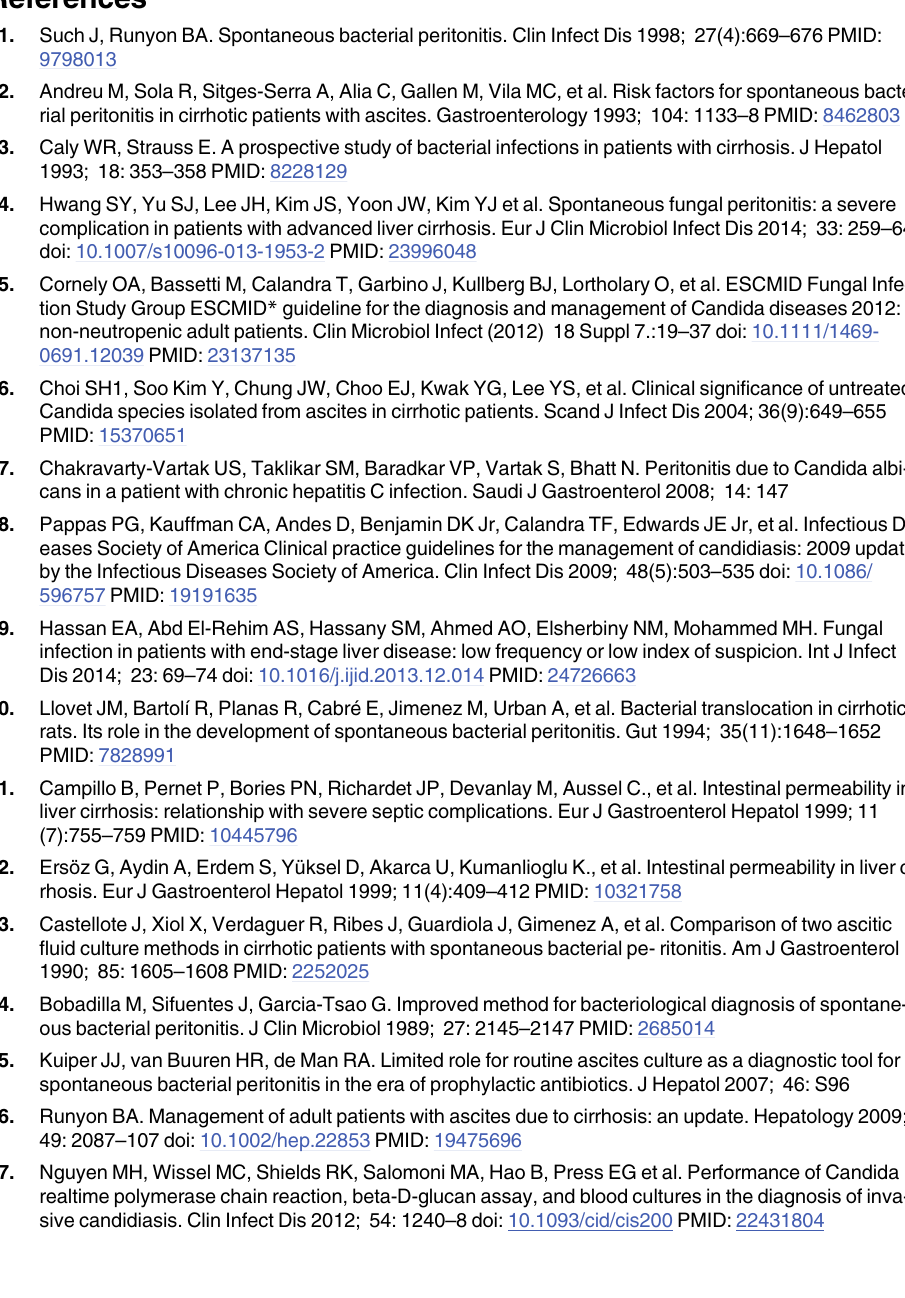
PLOS ONE | DOI:10.1371/journal.pone.0158389 July 8,